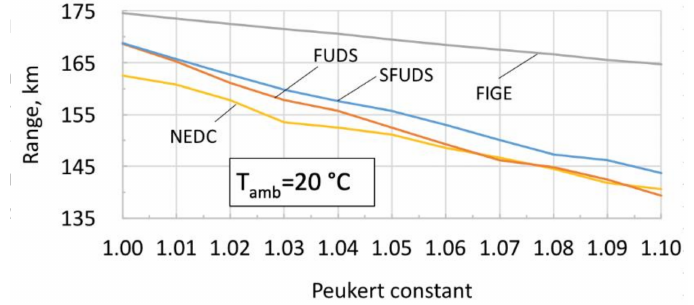
Figure 4. Driven range as a function of the Peukert constant k in the case of ambient temperature of 20 ◦ C.